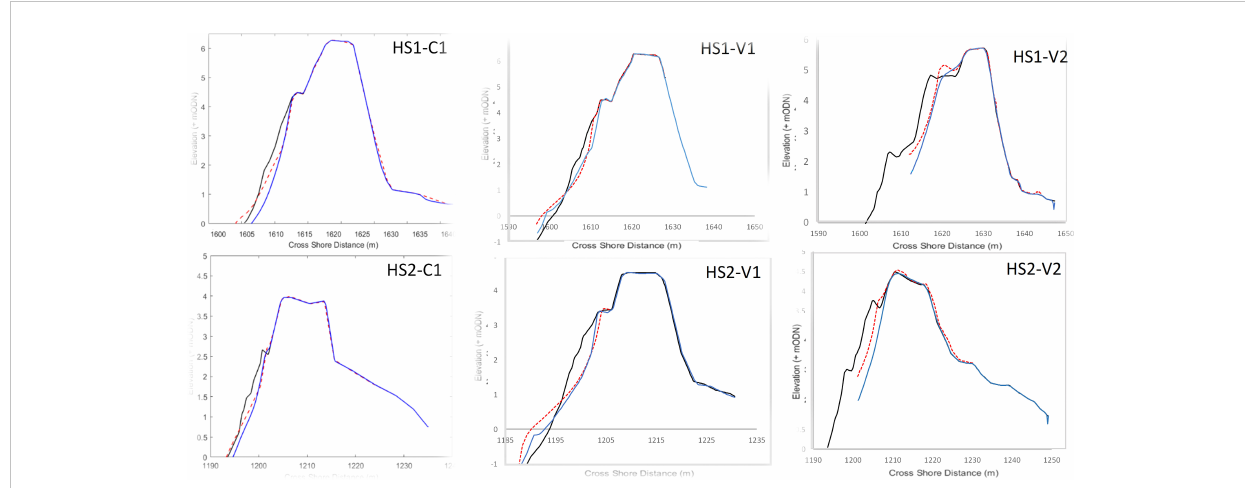
FIGURE 2 A comparison of measured and simulated post-storm pro fi les of HS1 and HS2 used for calibration (C1) and validation (V1 & V2) in Table 1. Measured pre-storm pro fi le (black line), measured post-storm pro fi le (red dotted line) and simulated post-storm pro fi le (blue